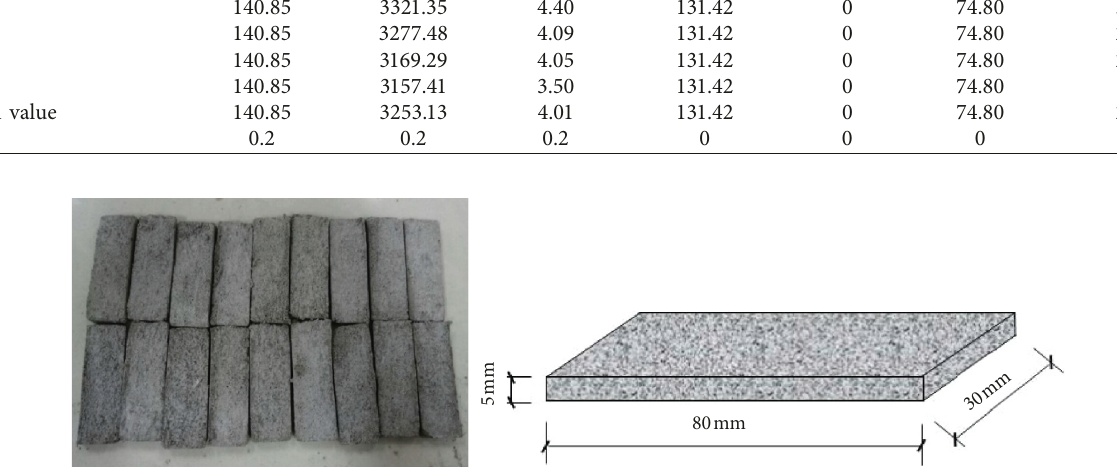
Figure 1: Specimens used in the experiment.